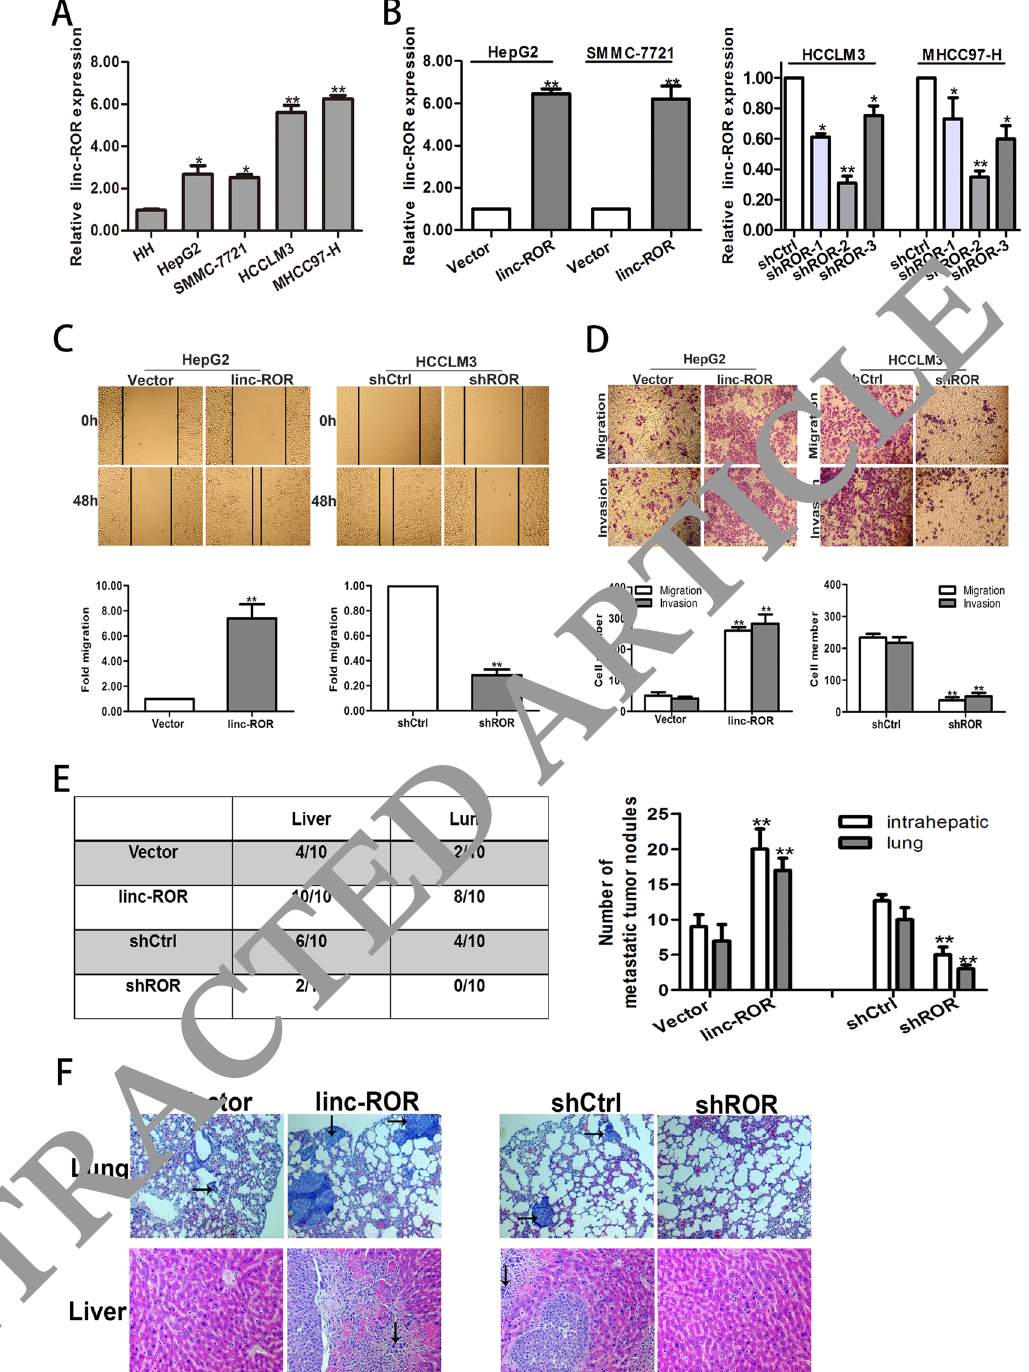
Figure 2. Linc-ROR promotes in vitro migration or invasion and in vivo metastasis in HCC cells. ( A ) HCC cell lines with different metastatic potentials and a normal human hepatocyte cell line (HH). Expression of linc-ROR was determined by qRT-PCR. ( B ) qRT-PCR detection of linc-ROR expression in HepG2 cells stably transfected with linc-ROR (or Vector) and HCCLM3 cells stably transfected with shROR (or shCtrl), respectively. ( C ) Wound healing assay on HepG2 cells stably transfected with linc-ROR (or Vector) and HCCLM3 cells stably transfected with shROR (or shCtrl), respectively. ( D ) Transwell migration and invasion assays on HepG2 cells stably transfected with linc-ROR (or Vector) and HCCLM3 cells stably transfected with shROR (or shCtrl), respectively. ( E ) Incidence and metastatic tumor nodules in different groups 8 weeks after orthotopic implantation. ( F ) Representative histological image of H&E staining. Black arrows: metastatic foci. Each experiment was performed at least three times. * p < 0.05; ** p <